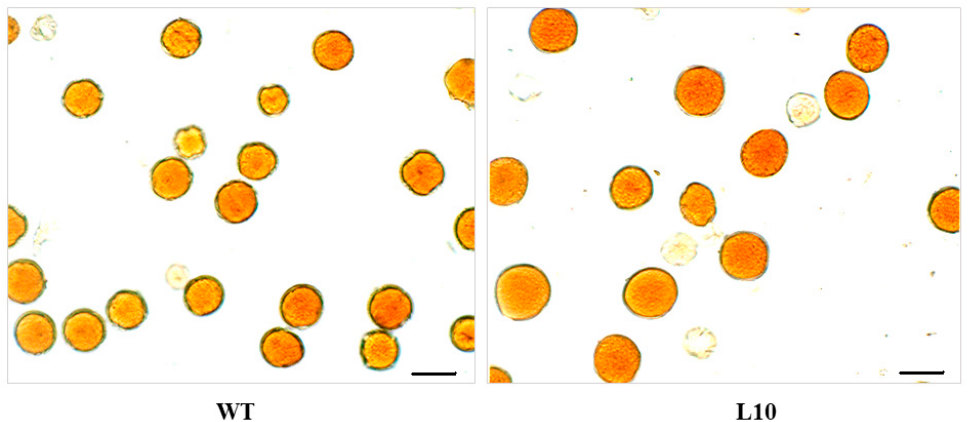
Table 1. Quantitative characteristics of pollen grains in tobacco plants with VlvSTS gene. Figure 8. Pollen stained with acetocarmine. WT—nontransformed plant, L10—transgenic plant transformed with VlvSTS gene. Bar = 30 μ m.